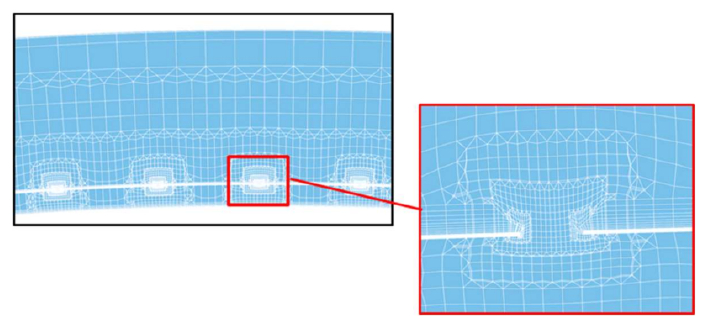
Figure 6. Cross-sectional view of computational grid for impingement manifold channel along circumferential direction using BOXERmesh, with close-up of impingement hole.